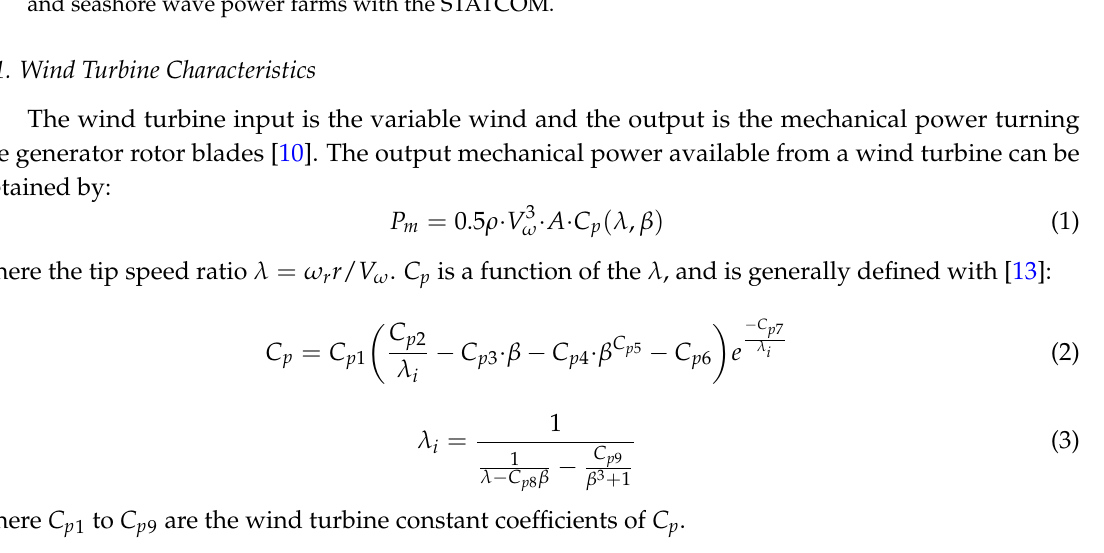
Figure 1. The 12-bus hybrid power multi-system connecting the integration of offshore wind farms and seashore wave power farms with the STATCOM.